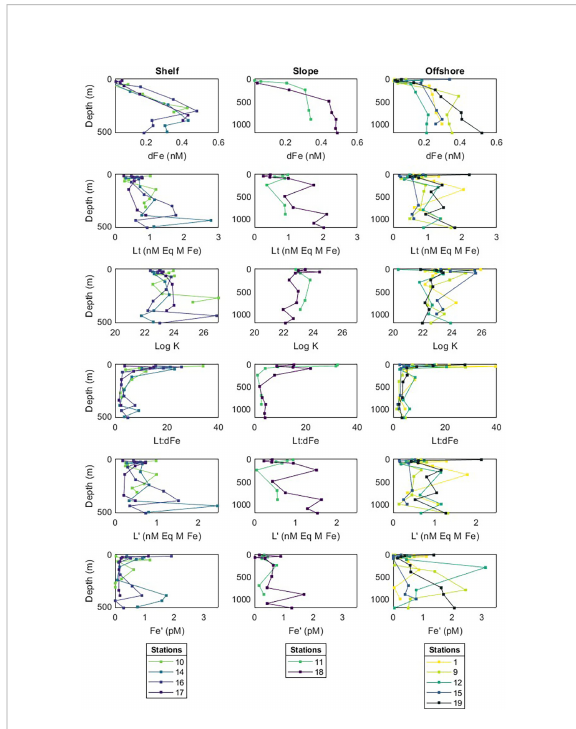
FIGURE 3 Depth pro fi les for dissolved Fe (dFe) and complexation parameters: total ligands (Lt), conditional stability constant (Log K FeL ), ratio of total ligands to dissolved Fe (Lt:dFe), ligands not bound to Fe (L ’ ) and Fe not bound to ligands (Fe ’ ). Stations have been divided into offshore, slope and shelf groups, as shown